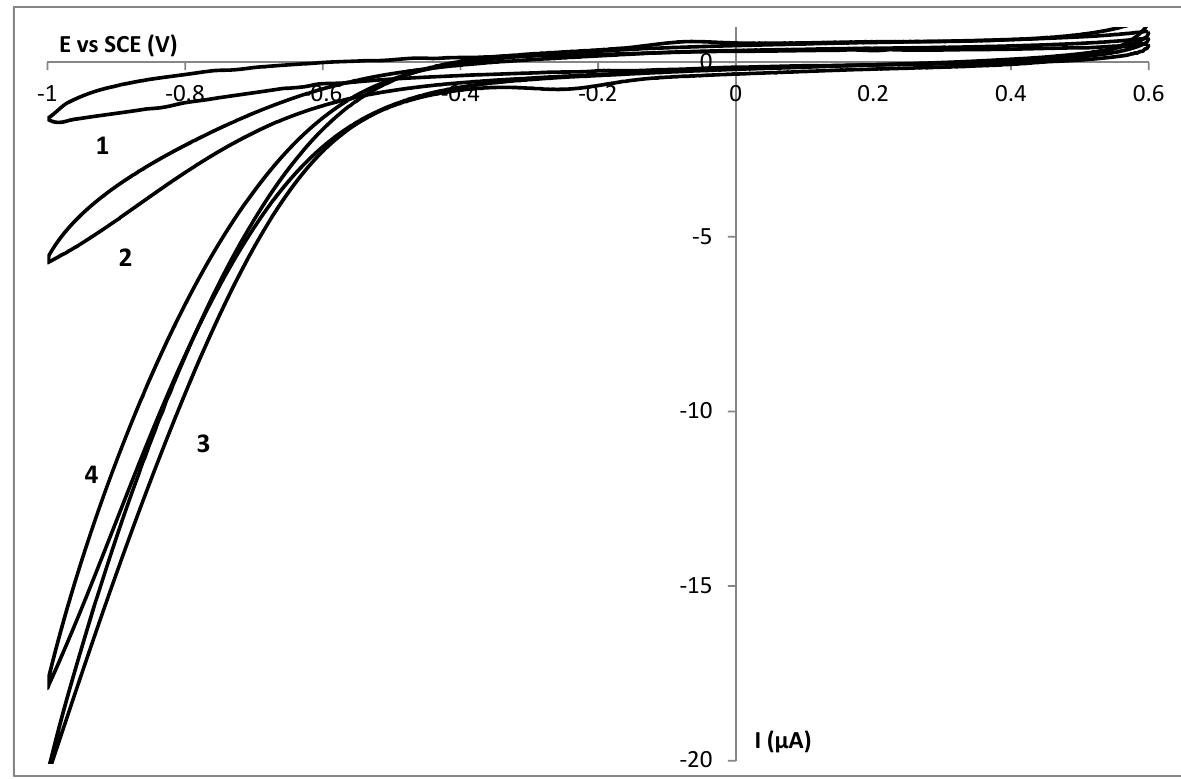
Figure 5. The current potential behavior of a spin coated GelB|C (1–2) and a spin coated Cat|GelB|C (3) electrode in the absence (1) and presence of 10.3 mmol·L − 1 H in a 10 mmol·L − 1 HEPES pH 7 buffer solution with a scan rate of 50 mV·s − 1 . Curve 4 is the current potential behavior obtained after curve 3 and polishing of the